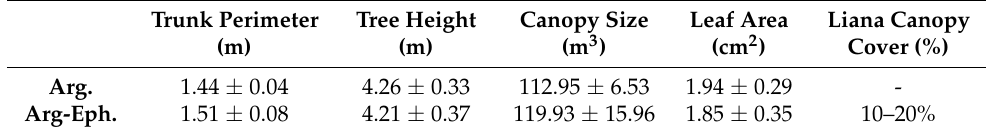
Table 1. Tree morphological traits (trunk perimeter, tree height, canopy size, leaf area), and liana canopy cover. Trunk Perimeter (m) Arg.